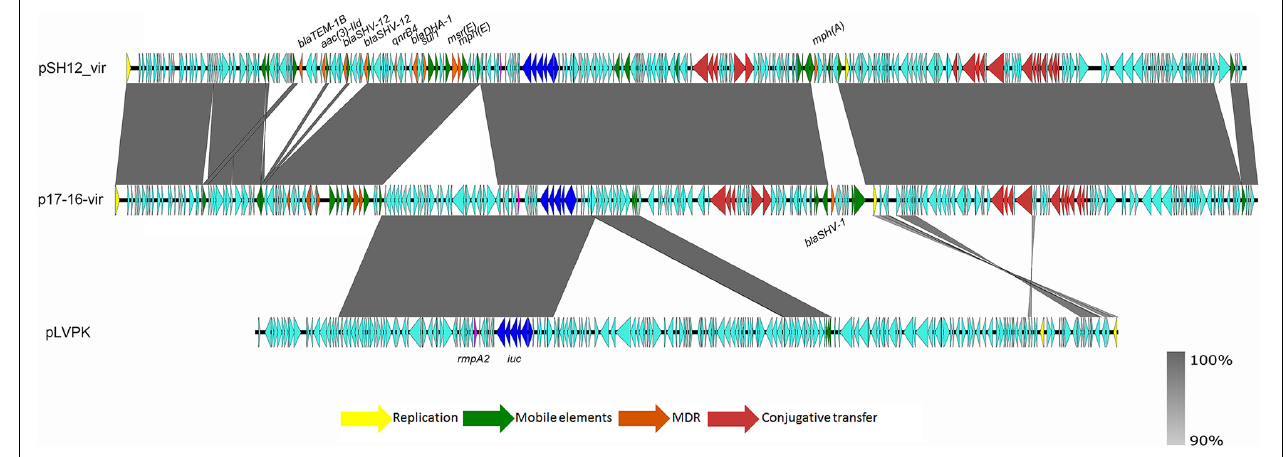
FIGURE 1 | Alignment of pSH12_Vir and plasmids with similar structures. Plasmid pSH12_Vir was an IncFIB/IncHI1B plasmid with several mosaic MDR regions and virulence factors. Genetic regions associated with virulence and resistance are highlighted. TABLE 2 | Comparison of plasmids pSH12_Vir and pSH12_KPC with similar plasmids in the GenBank database. Plasmid ID